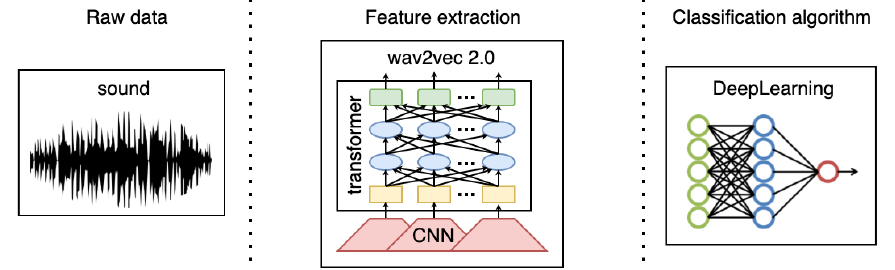
Figure 5. Pipeline for emotion detection from audio signals using wav2vec 2.0 [41]. First, raw data must be identified, i.e., the wav audio itself. Then, the characteristics are extracted with